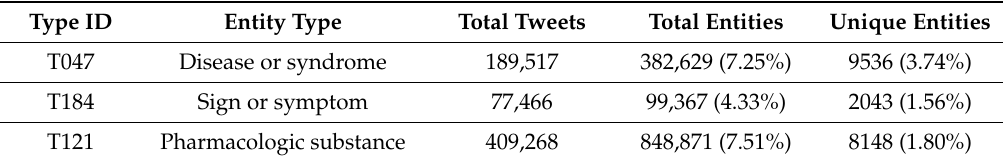
Table 1. Medical entity